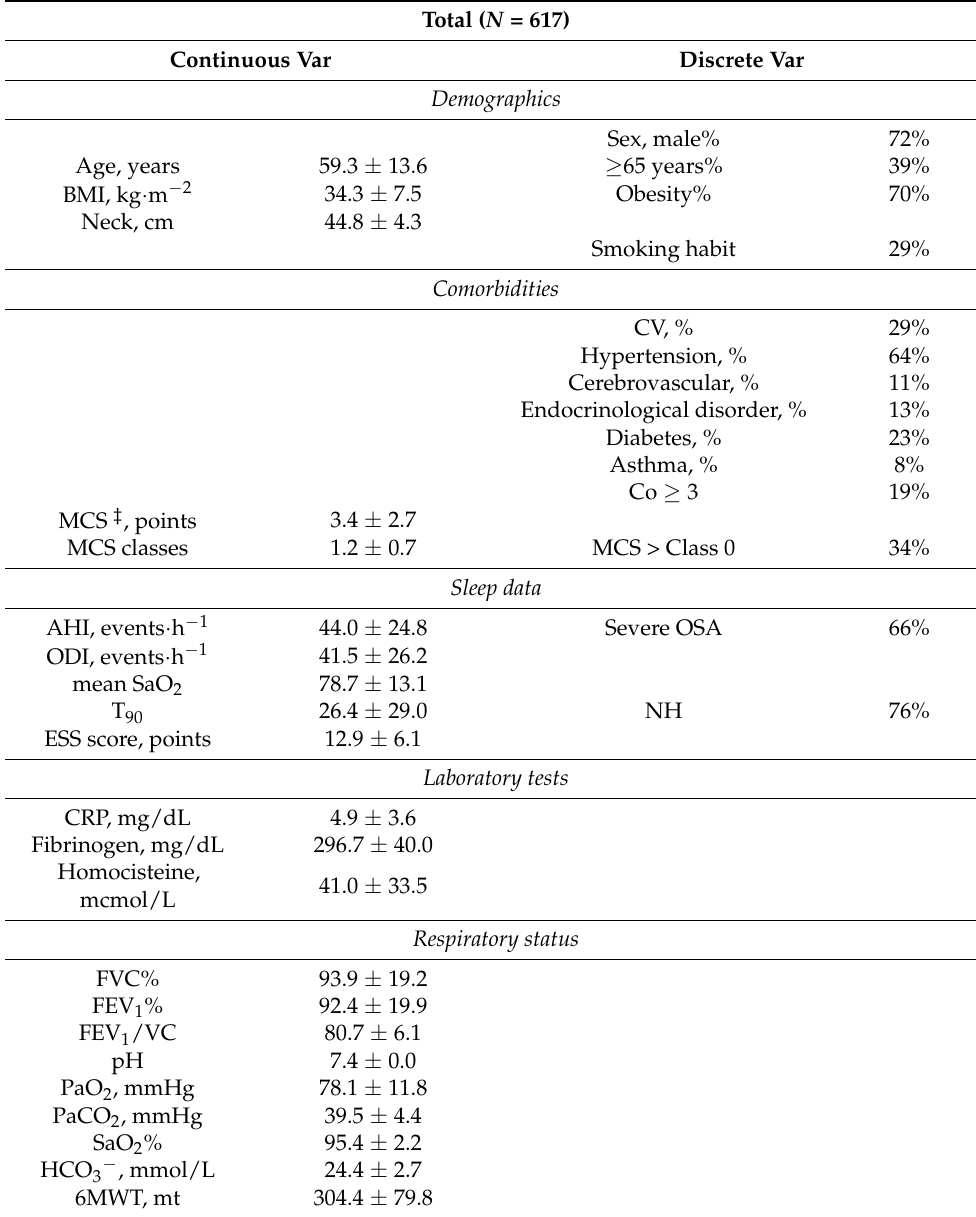
Table 1. Characteristics of